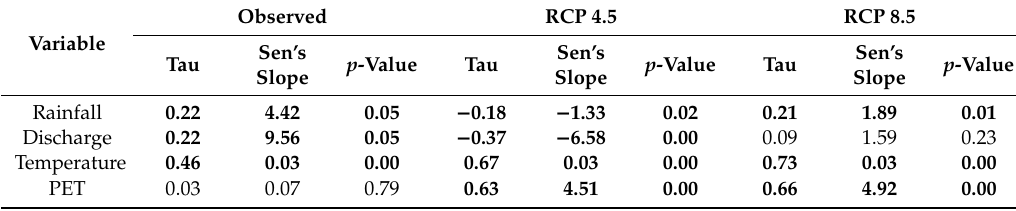
Table 10. Trend in annual rainfall, discharge, temperature and potential evapotranspiration.